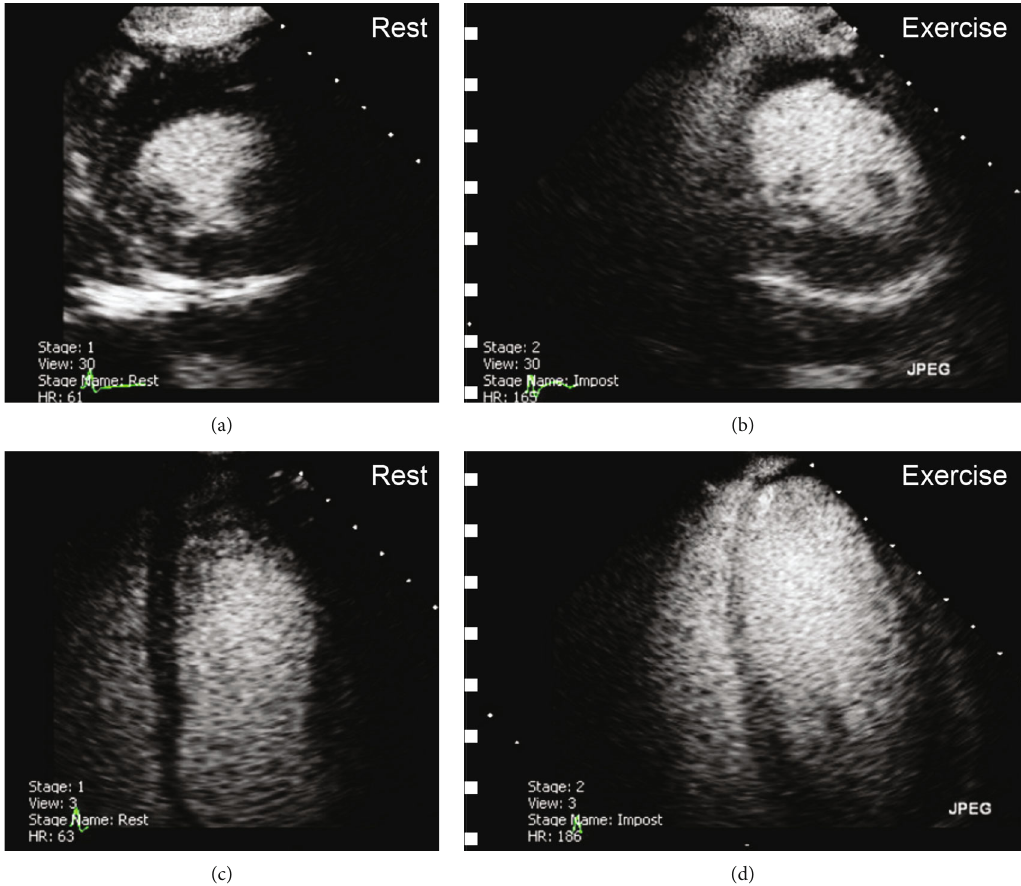
Figure 3: Stress echocardiogram with contrast. Parasternal mid left ventricular short axis slices (a, b) and 4-chamber views (c, d). Images (a) and (c) are taken at rest. Images (b) and (d) are taken at peak exercise, demonstrating apical